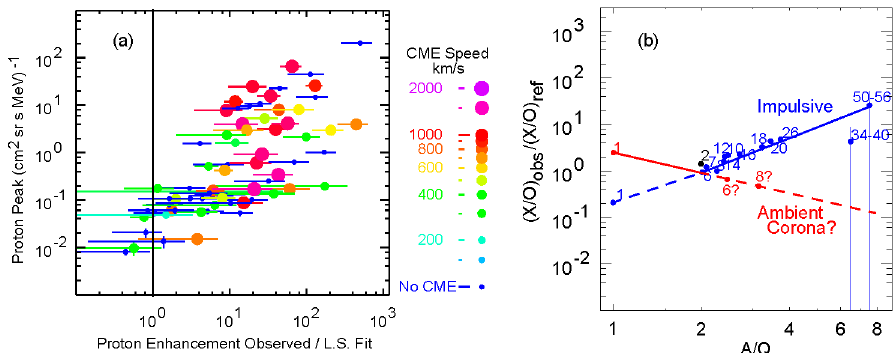
Figure 5. Proton excesses for impulsive SEP events and their possible origin: ( a ) Peak intensity vs. proton excess shows large excesses for more intense SEP events produced when fast coronal mass ejections (CMEs) can drive shocks. ( b ) Shocks preferentially reaccelerate pre-enhanced impulsive SEP ions, plus additional protons from the ambient coronal plasma to produce the observed proton excesses [74,75].